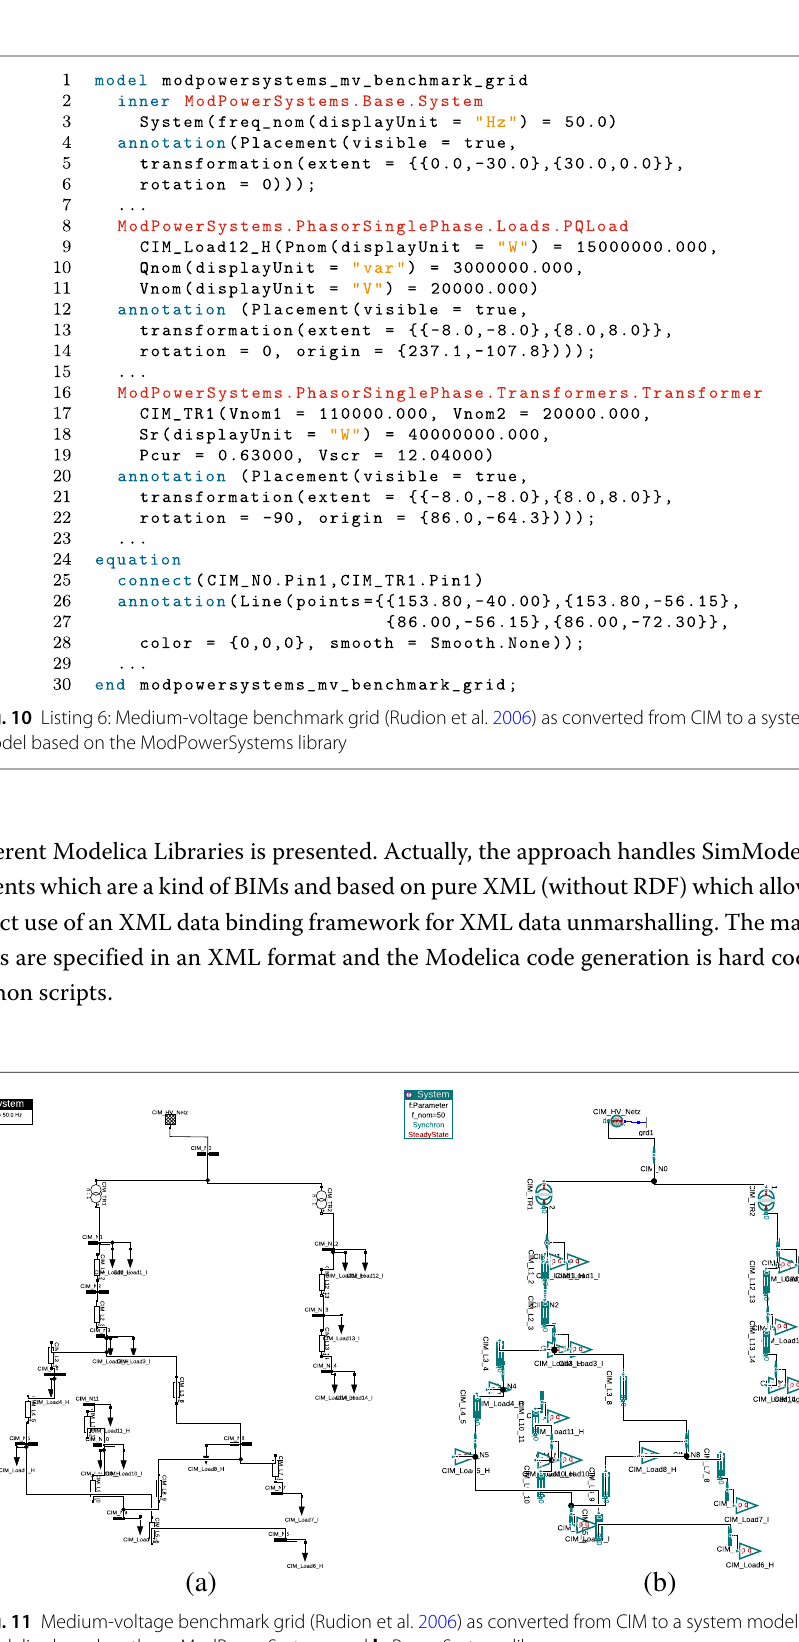
Fig. 11 Medium-voltage benchmark grid (Rudion et al. 2006) as converted from CIM to a system model in Modelica based on the a ModPowerSystems and b PowerSystems